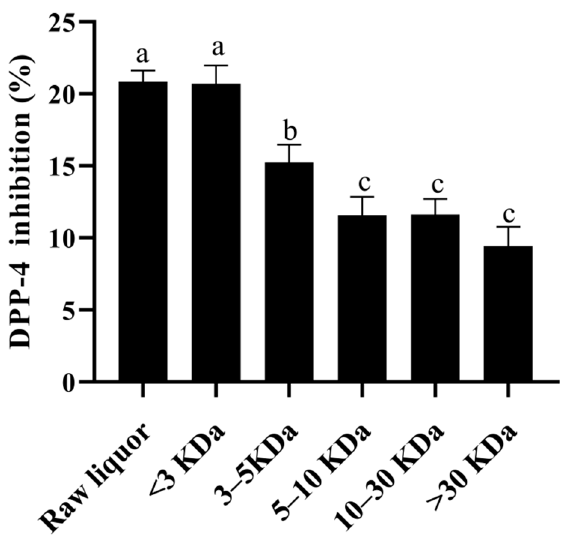
Figure 6. Effects of the cell-free extracts (CFEs) collected from L. plantarum YE4 (YE4-CFE) with different molecular weight components on the inhibitory activity of DPP-4. CFEs, cell-free extracts; YE4-CFE, the CFE of L. plantarum YE4. Each value represents the mean ± standard deviation ( n = 3). Different letters (a–c) indicate significant differences ( p < 0.05). Table 1. Compounds with a relative proportion higher than 1% in YE4-CFE with a molecular weight of less than 3 kDa by UHPLC-MS/MS.